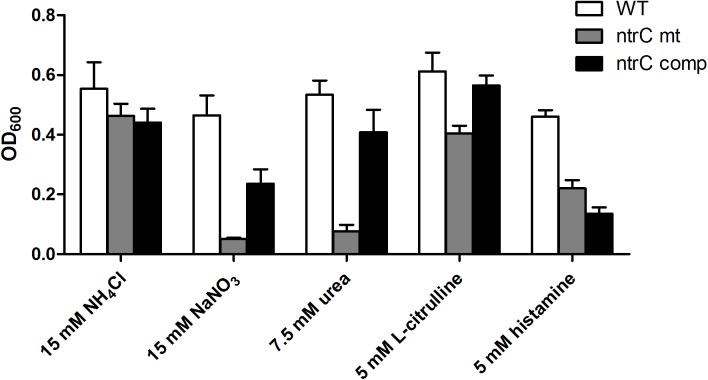
Nitrogen sources differentially utilised by the wild-type, ntrC mutant and the complemented strains.Cells were grown at 37°C for 4 days with slow agitation in order to synchronize the growth. 3 independent cultures of each strain were tested with each N source. Columns and error bars indicate the average and the standard deviation of final OD600, respectively.